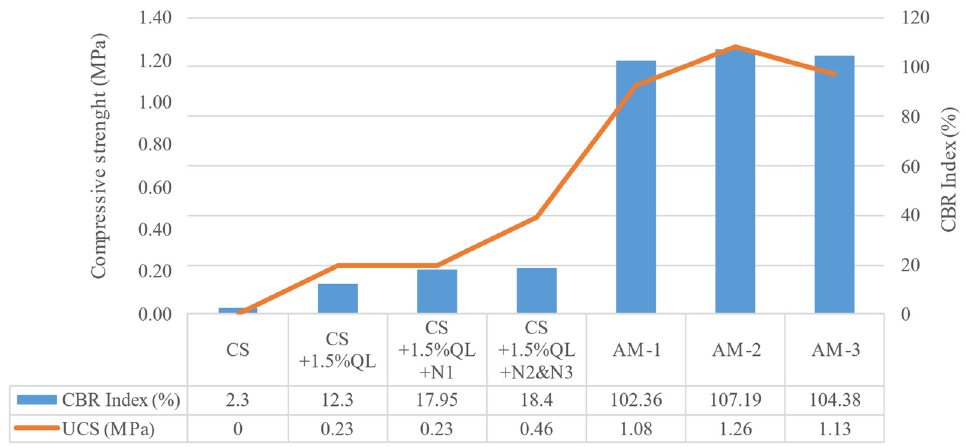
Figure 8. CBR index and compressive strength.